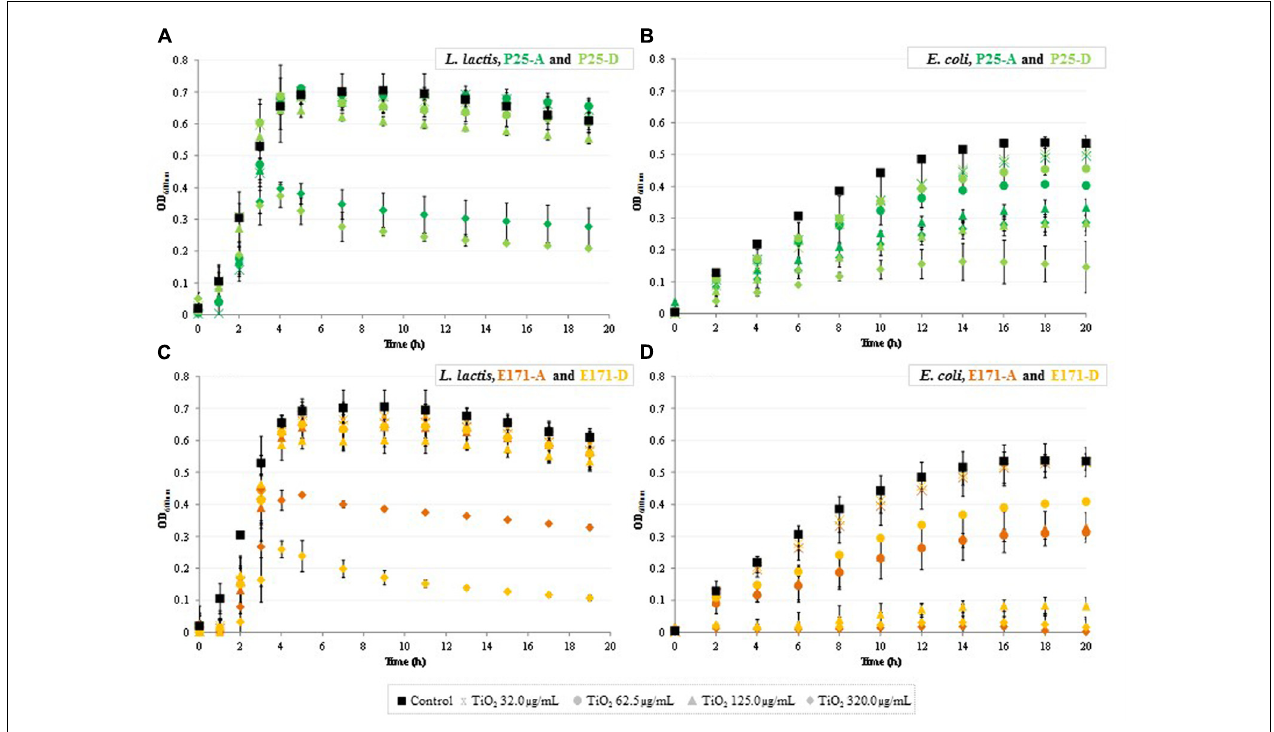
FIGURE 2 | Growth kinetics of bacterial cells after TiO 2 exposure. (A,B) L. lactis IBB477 and (C,D) E. coli K12 MG1655 subjected to 0.0 (black squares), 32.0 (crosses), 62.5 (circles), 125.0 (triangles), and 320.0 (diamonds) µ g/mL TiO 2 -NPs P25 ( A,C in green) or food-grade E171 ( B,D in orange) in aggregated (dark color) vs. dispersed (light color) forms. Data are the means ± SD. See Supplementary Material 2 for statistical analysis.